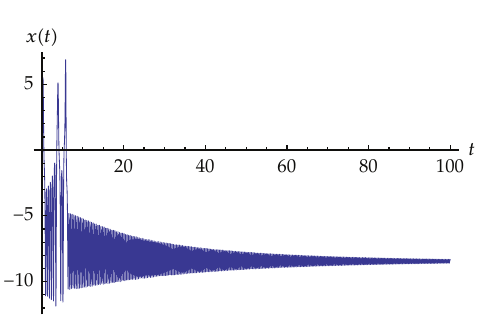
Figure 8: Controlled signal α (cid:8) 1 (cid:3) k (cid:8) 22 (cid:4) .